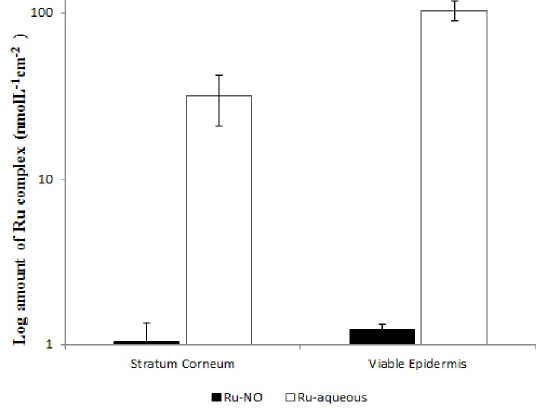
Figure 7. Ru-NO and Ru-aqueous recovered from the SC and viable epidermis after 4 h of iontophoresis. Table 1. Ru-aqueous and Ru-NO amount quantified in the receptor solution after 4 h of passive or iontophoretic permeation with the same initial molar concentration (mean ± SD, n = 5).